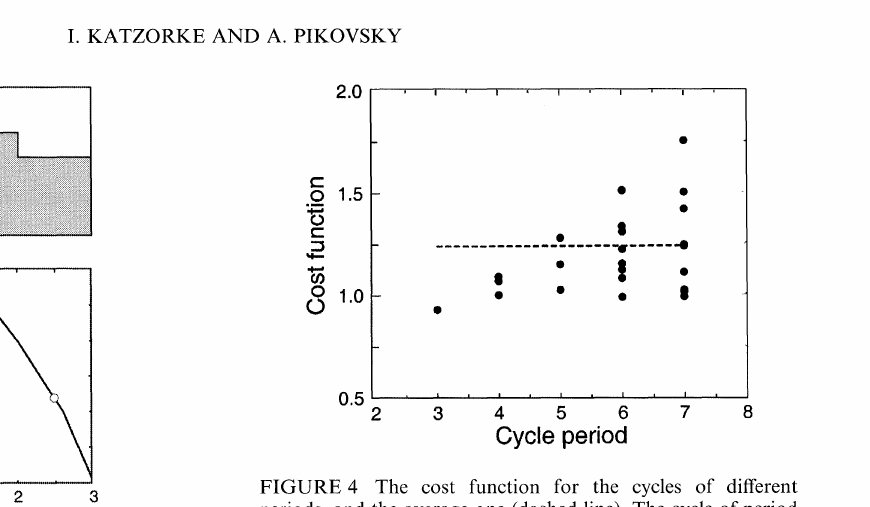
FIGURE 4 The cost function for the cycles of different periods, and the average one (dashed line). The cycle of period 3 yields the global minimum. --+ 2 + 3